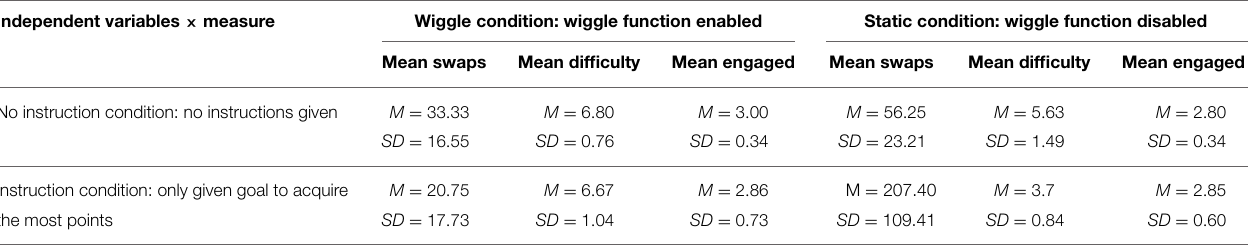
TABLE 1 | Cell means and standard deviations for task-dependent performance and experience measures. Independent variables ×